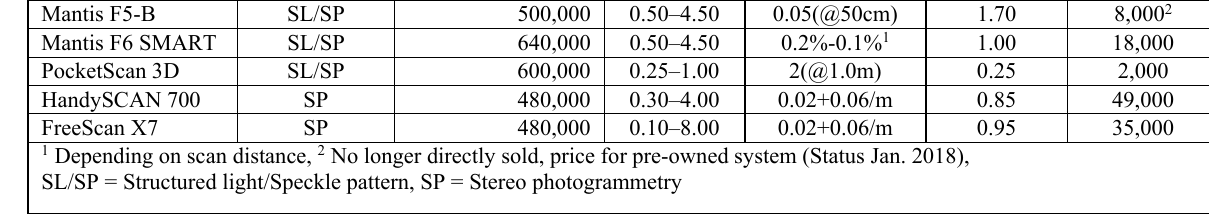
Table 1. Selected technical specification of the examined hand-held 3D scanning systems (manufacturer´s data)